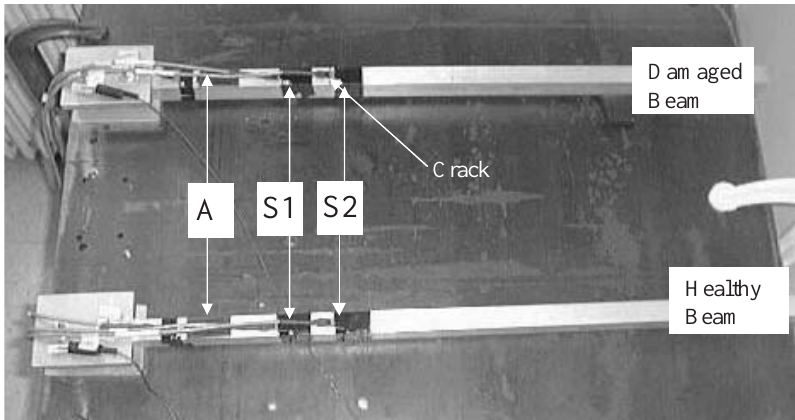
Fig. 4. Experimental